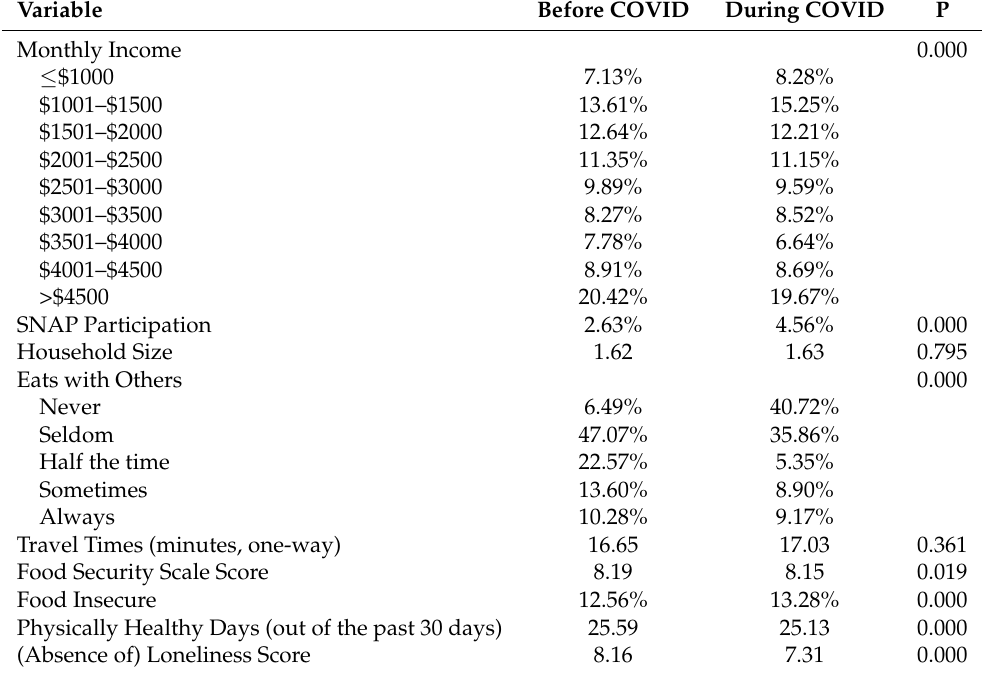
Table 4. Changes after the onset of